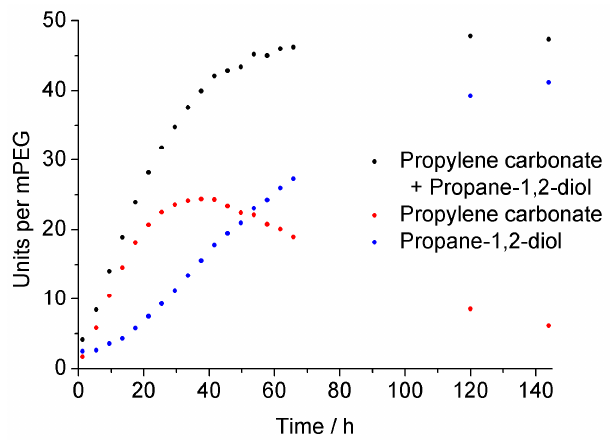
Figure 5. In situ 1 H-NMR degradation study of mPEG 113 - b -PPC 49 (Table 1, sample 3) in conc. DCl. Comparison of the degradation products propylene carbonate (red), propane-1,2-diol (blue) and both together (black) in units per mPEG 113 .